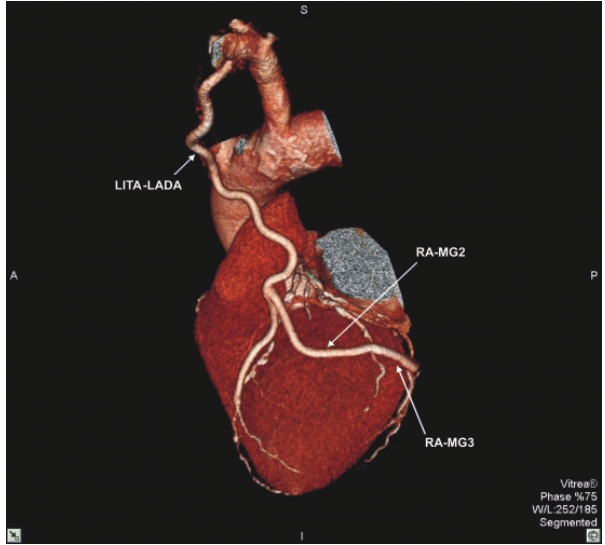
Figure 1 - Three dimensional computed tomography image for Left Internal Thoracic Artery to Left Anterior Descending Artery (LITA – LADA) and Radial Artery to marginal branches 2 and 3 (RA – MG2; RA – MG3).